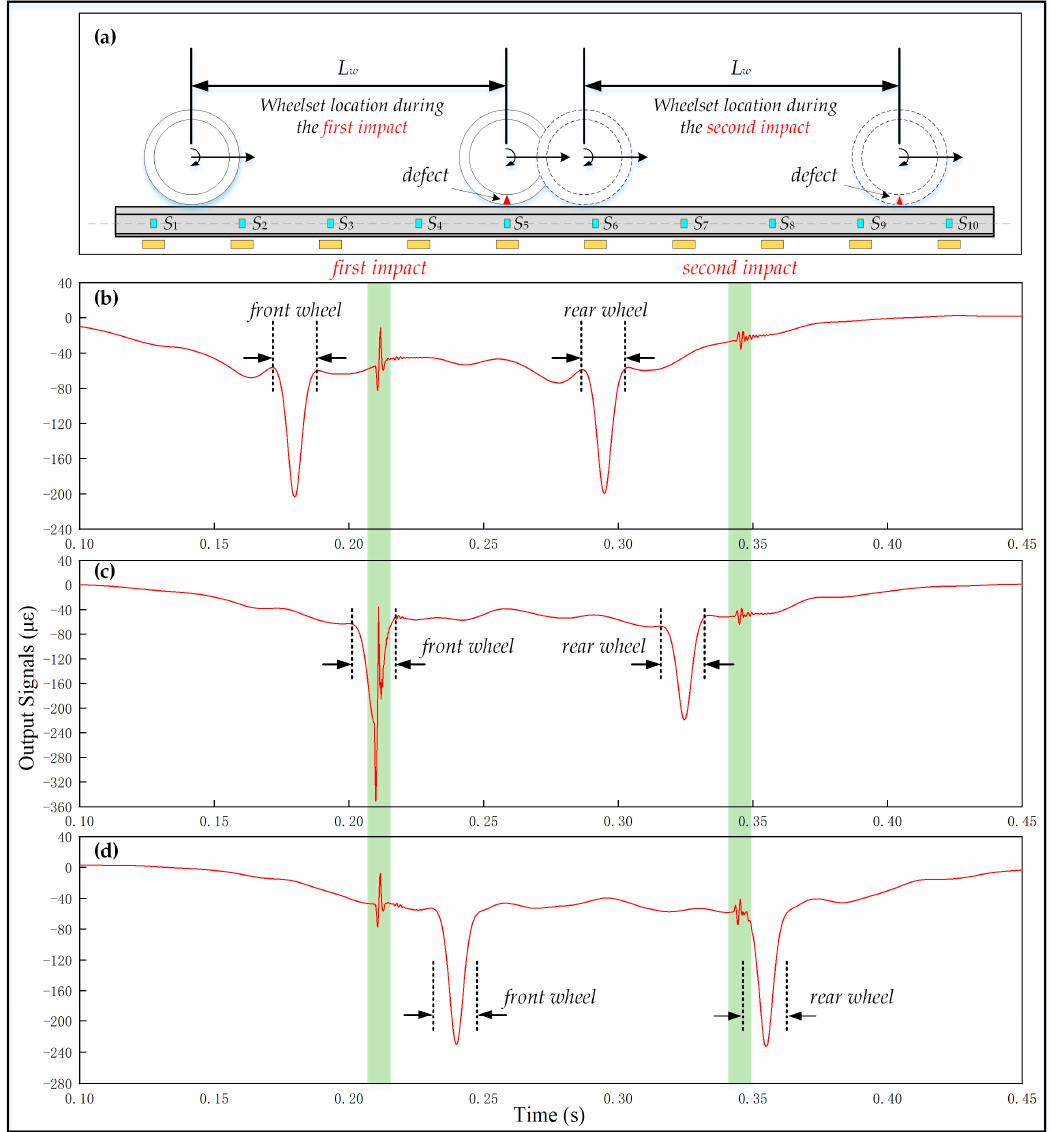
Figure 15. ( a ) The movement of the wheelset and the layout of the multisensor array, the output signals of ( b ) sensor S 4 ; ( c ) sensor S 5 ; and ( d ) sensor S 6 .